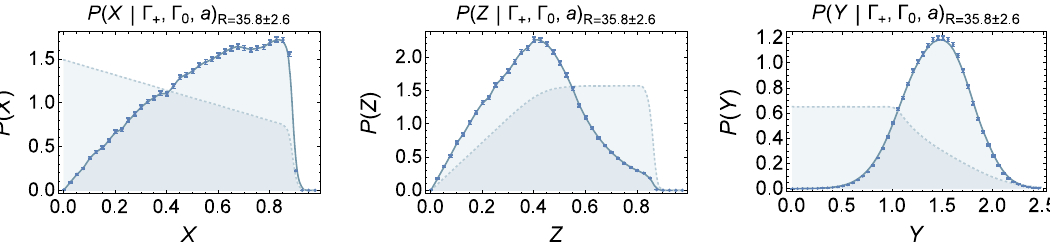
Fig. 3 Probability densities in comparison with the prior (transparent). R = 35 . 8 ± 2 . 6, η → 3 π data. Smoothed. Error bars estimate the precision of the Monte Carlo